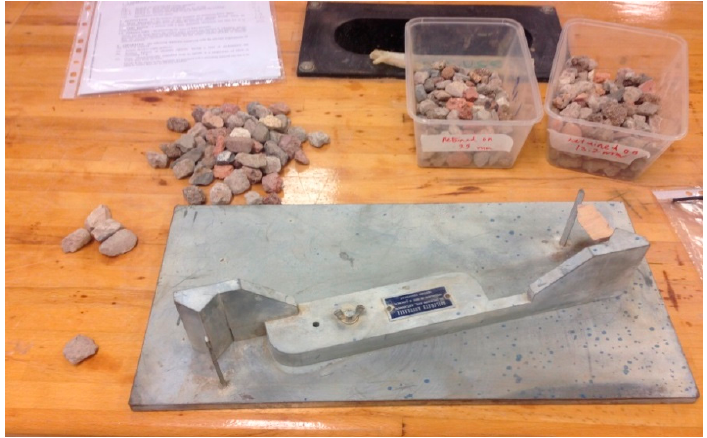
Figure 4. Classification of Aggregate Based on Particle Shape Test. Table 2. The Results of Particle Shape Test for Coarse Aggregates and Misshapen Percentage Limits for Dense Graded Asphalt Based on Australian Standards.